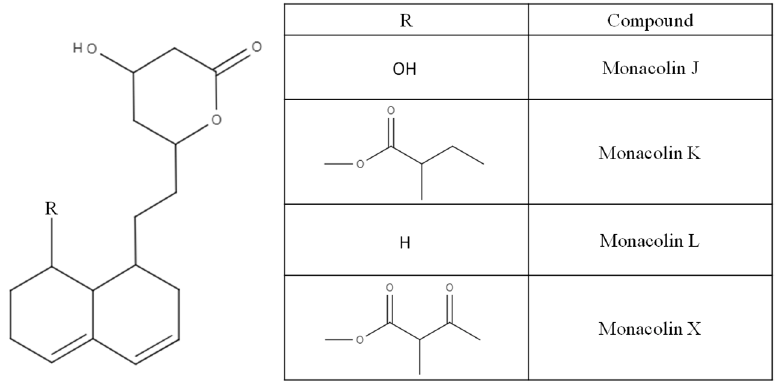
Figure 6. Monacolins (polyketides) produced by Monascus fungi.